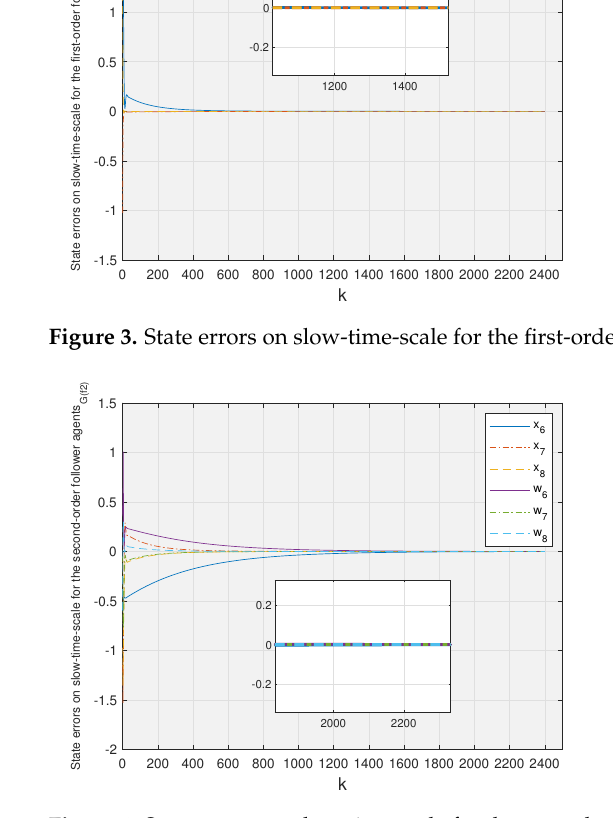
Figure 4. State errors on slow-time scale for the second-order follower